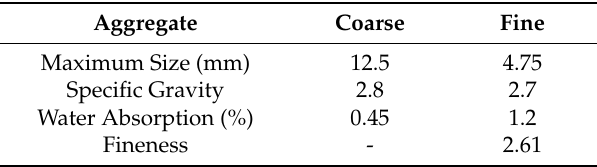
Table 1. Coarse and fine aggregate properties.